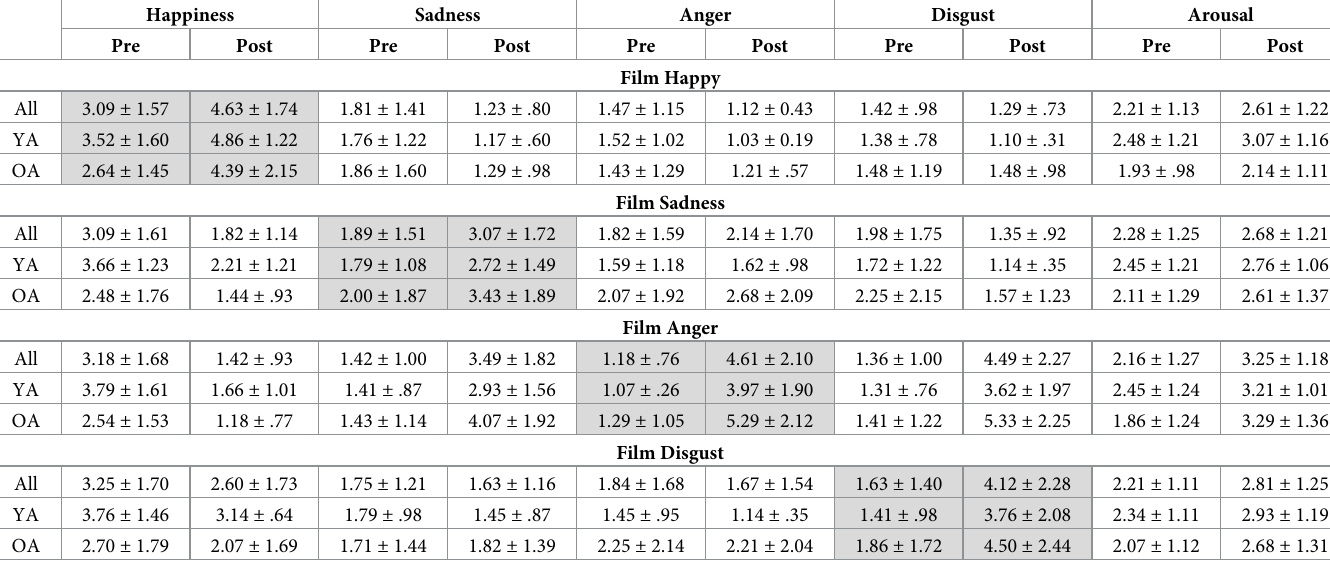
OA = older adults, YA = young adults; target emotions for each video in